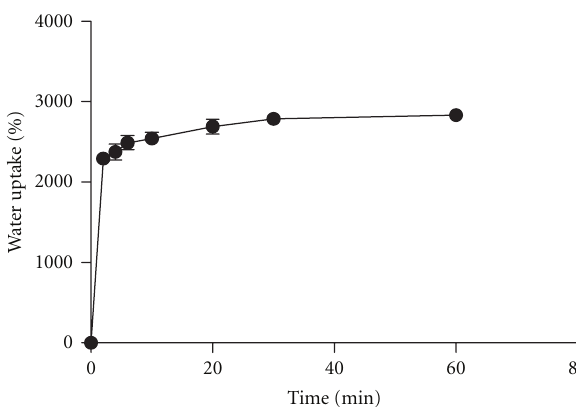
Figure 4: Water uptake curve of chitosan/alginate microparticle in SBF. Each data point represents the mean of 3 samples ± SD.